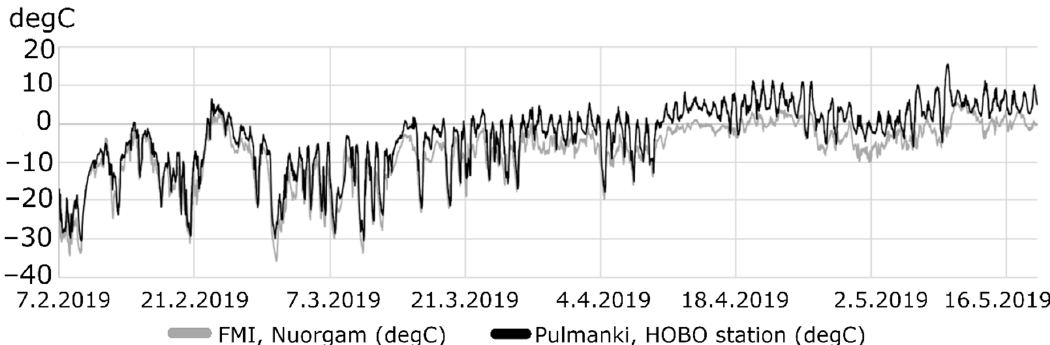
Figure 4. The temperatures compared in more detail between the FMI’s station at Nuorgam and the Pulmanki River’s HOBO station measurements. The diurnal temperature variation is greater in the Pulmanki River valley than at the FMI’s station.